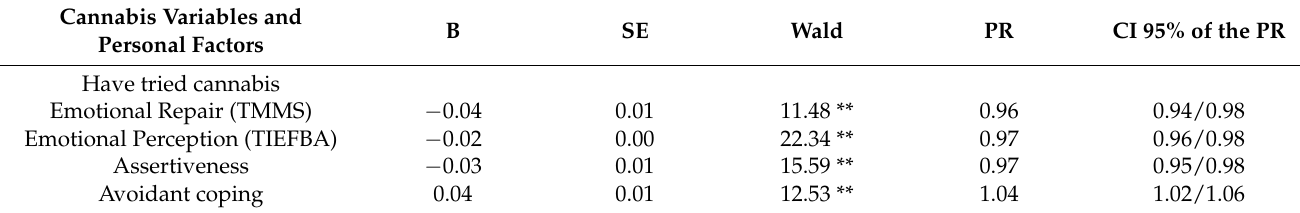
Table 5. Binomial regression analysis based on the 14–16 years age